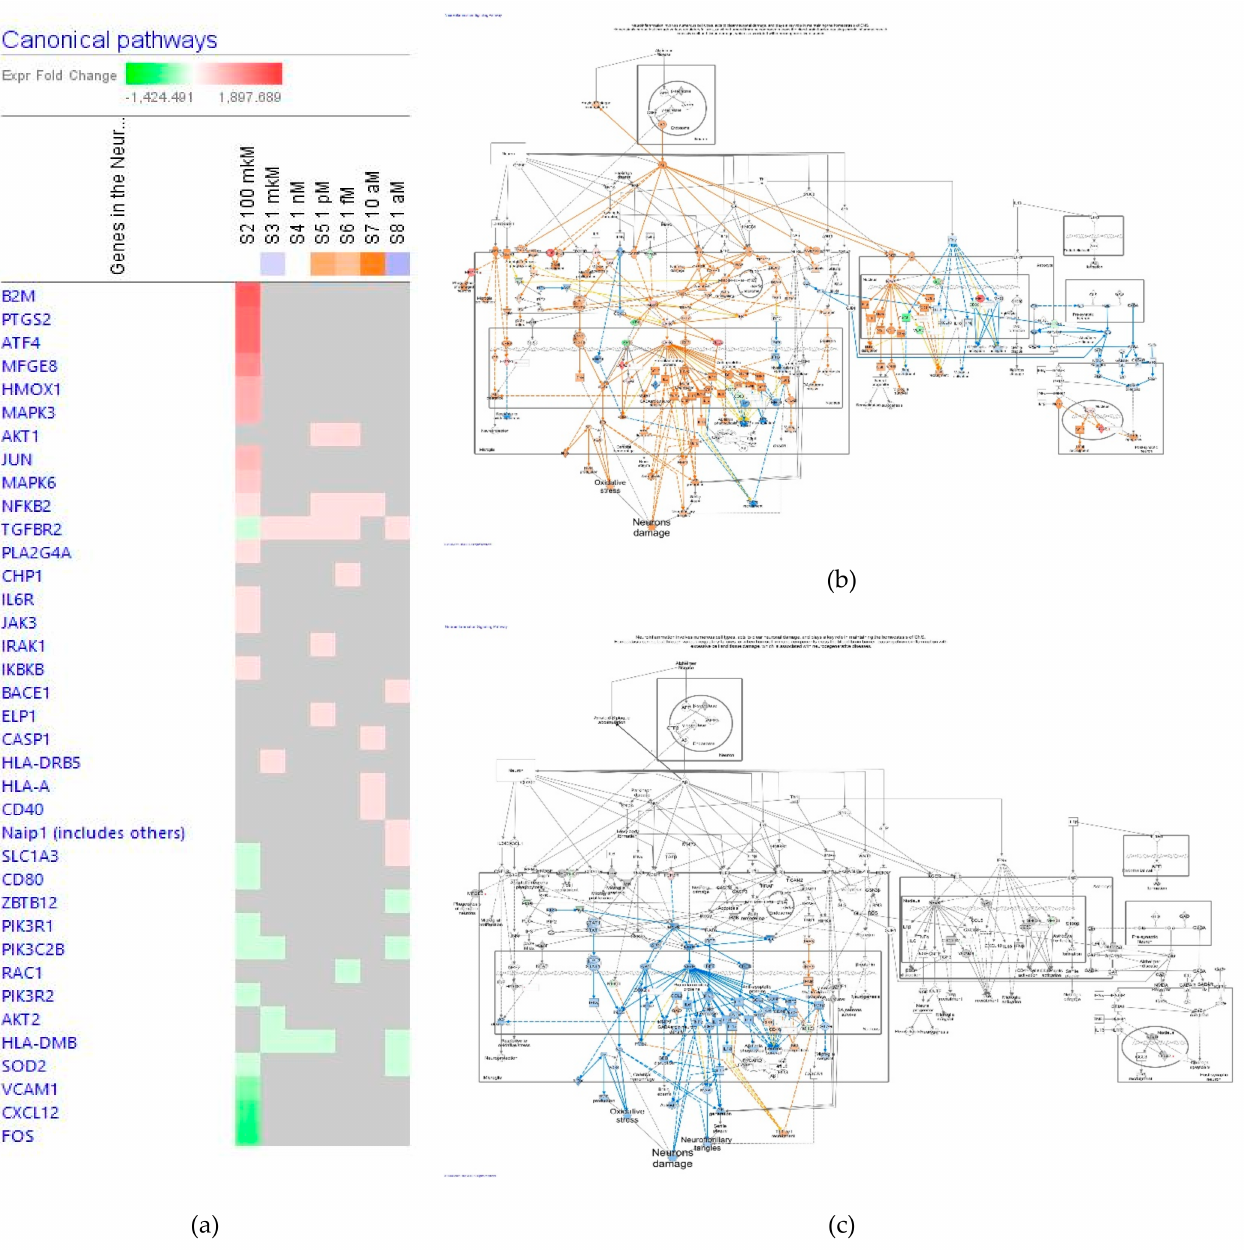
Figure 6. Effect of Rg5 on neuroinflammation signaling pathway: ( a ) Heatmap of gene expression (in fold changes compared to control, red, upregulation and green, downregulation), after exposure with ginsenoside Rg5 at different concentrations; the 100 µ M signature is shown in the leftmost column as solid red or green squares indicating genes that are upregulated or downregulated, respectively; color intensity indicates the actual log-fold changes; ( b ) Rg5 in the concentration of 100 µ M—predicted inhibition (blue) and activation (brown); ( c ) Rg5 at a concentration of 1 µ M—predicted inhibition (blue) and activation